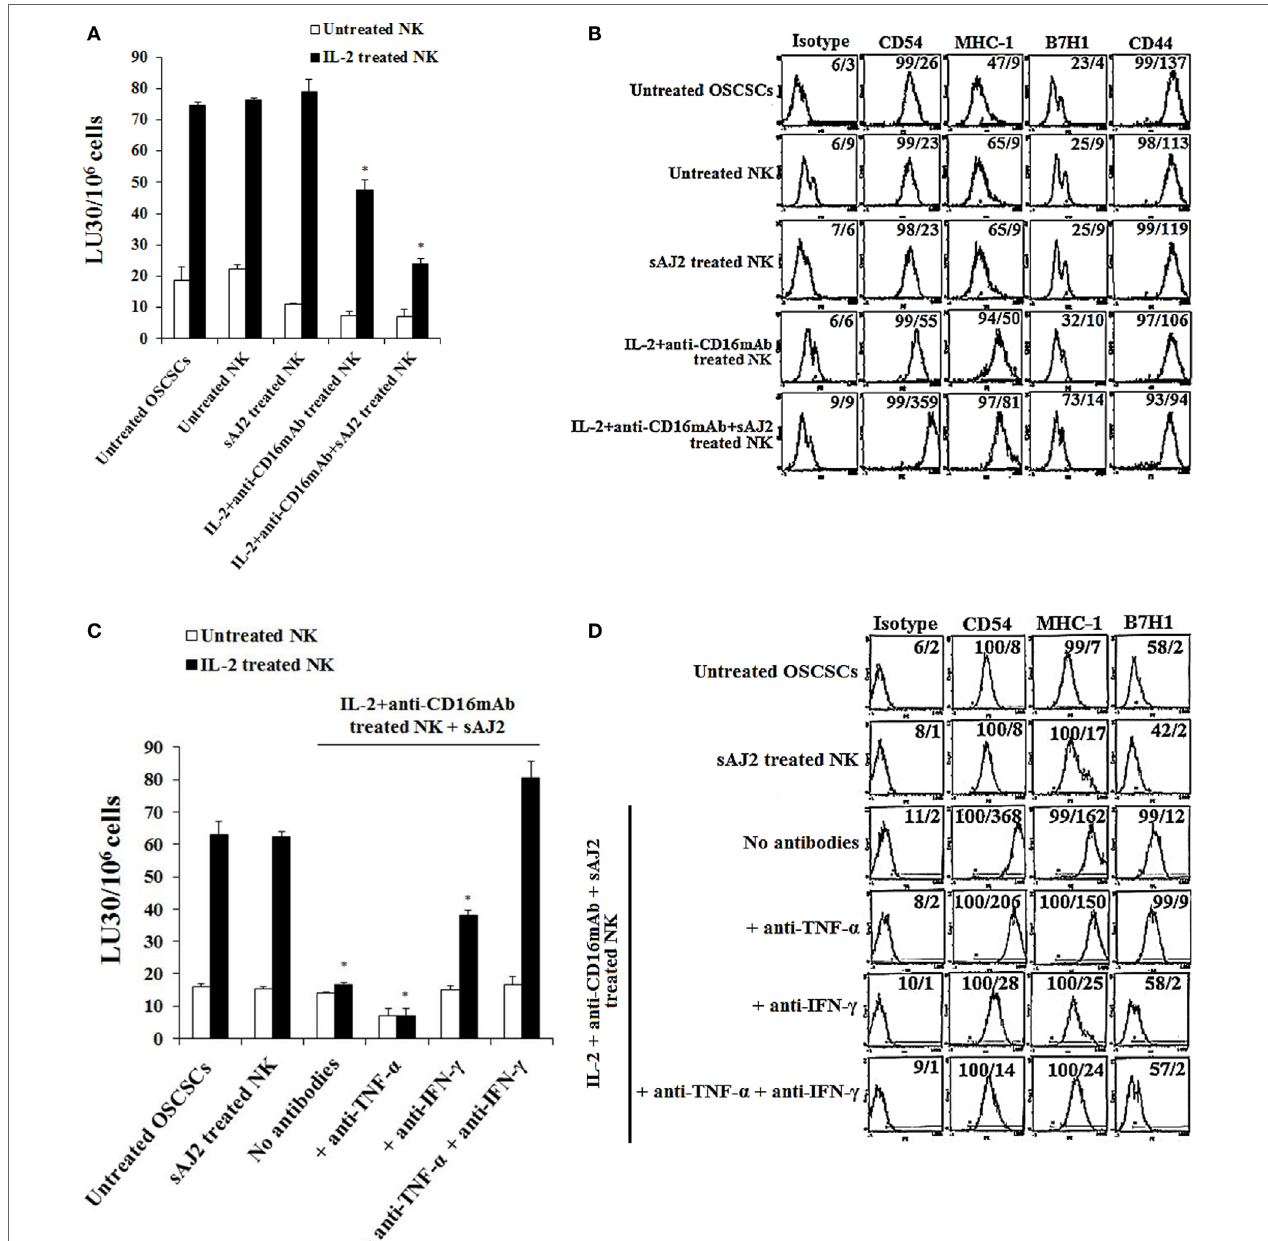
FigUre 2 | resistance to nK cell-mediated lysis of Oscscs treated with supernatants from il-2 + anti-cD16mab + saJ2-stimulated nK cells is mediated by the combination of iFn- γ and TnF- α and not each cytokine alone . Highly purified NK cells were left untreated or treated with IL-2 (1,000 U/mL) and anti-CD16mAb (3 μ g/mL) with or without sonicated AJ2 (sAJ2) at 1:3 (NK:sAJ2) ratio for 18 h before the supernatants were harvested and added to OSCSCs for 4 days. Afterwards, untreated OSCSCs and those treated with different NK cell supernatants indicated in the figure were detached from the tissue culture plates, extensively washed with 1 × PBS and labeled with 51 Cr. Freshly isolated NK cells were left untreated or treated with IL-2 (1,000 U/mL) for 24 h before the cells were used as effector cells in 51 Cr release assay against OSCSCs treated with NK supernatants. The lytic units 30/10 6 cells were determined using inverse number of NK cells required to lyse 30% of the target cells × 100. Differences between untreated OSCSCs and those cultured with IL-2 + anti-CD16mAb-treated NK or those stimulated with IL-2 + anti-CD16mAb + sAJ2-treated NKs were significant at a P -value of < 0.05 (*) (a) . OSCSCs were differentiated as described in (a) , and after 4 days the surface expression of CD54, MHC-1, B7H1, and CD44 on untreated OSCSCs or those treated with NK cell supernatants as shown in the figure was assessed after staining with the PE-conjugated antibodies and analyzed using flow cytometry. Isotype control antibodies were used as controls. The numbers on the right hand corner are the percentages and the mean channel fluorescence intensities for each histogram (B) . NK cells were treated with sAJ2 alone at 1:3 (NK:sAJ2) ratio or treated with IL-2 (1,000 U/mL) and anti-CD16mAb (3 μ g/mL) and sAJ2 at 1:3 (NK:sAJ2) ratio in the presence of anti-TNF- α (1:100), anti-IFN- γ (1:100), or combination of anti-TNF- α (1:100) and anti-IFN- γ (1:100) as shown in the figure for 18 h. Afterwards, NK cell supernatants were harvested and added to OSCSCs for 4